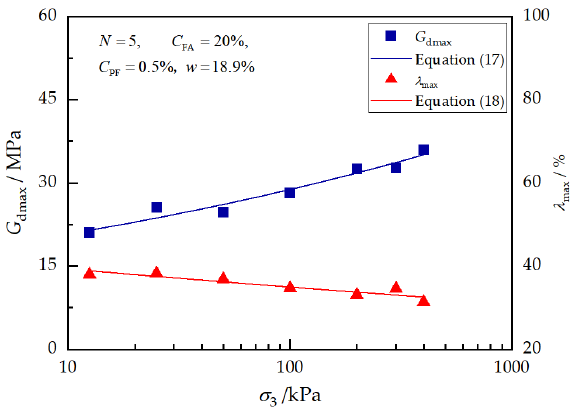
Figure 14. Effects of confining pressure on